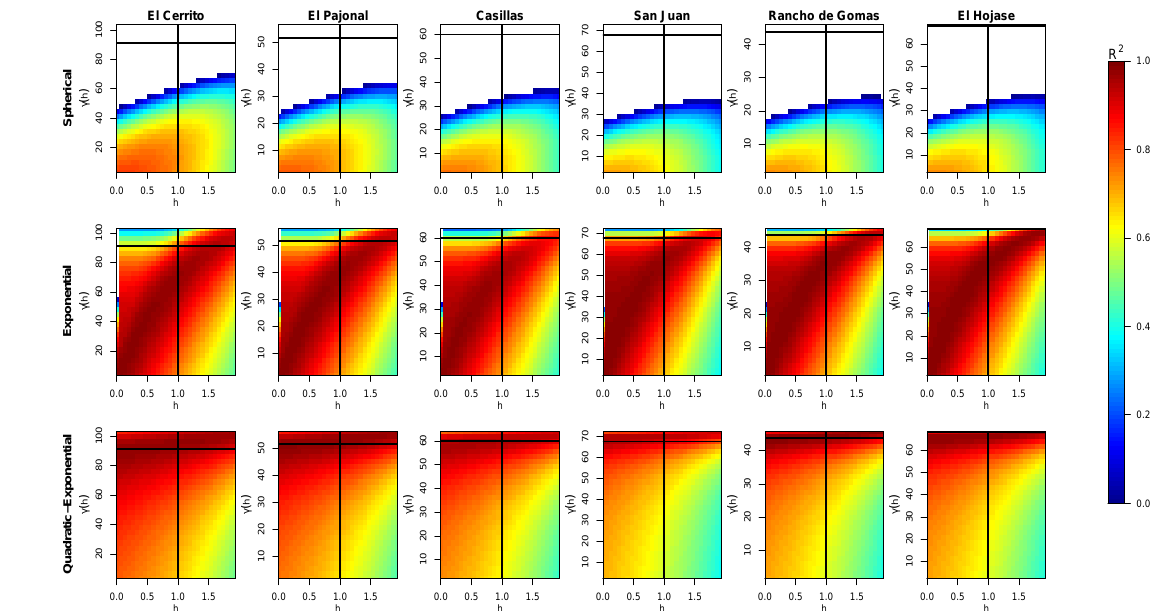
Figure 6. Obtained values of R 2 (color bar) for different pair of data R 0 = ( r 0 , γ ( r 0 )) when fitting a curve for the variogram of each station with the three models and without considering the nugget effect. The intersection of the black solid lines tags the real R 0 in our experimental variogram. The white areas (in the results of the spherical model) correspond to lower values than those shown on the color scale, i.e., lower than zero.